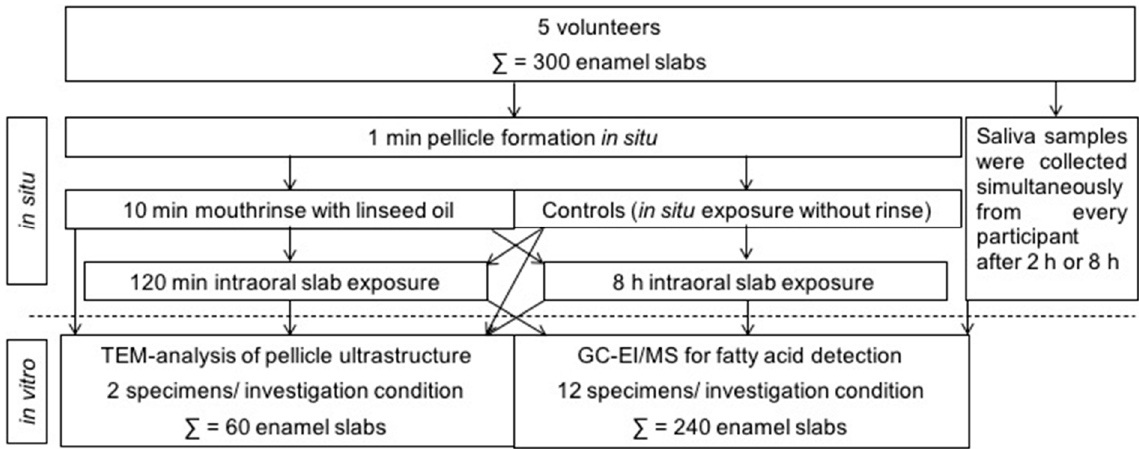
Figure 1. Overview of the experimental setup performed in this study. In situ pellicle and initial biofilm samples were obtained from 5 volunteers, who all underwent the different investigation conditions. In total, 300 enamel slabs were used in this study. Table 1. Fatty acid composition of major fatty acids (in %, in relation to total fatty acids) in linseed